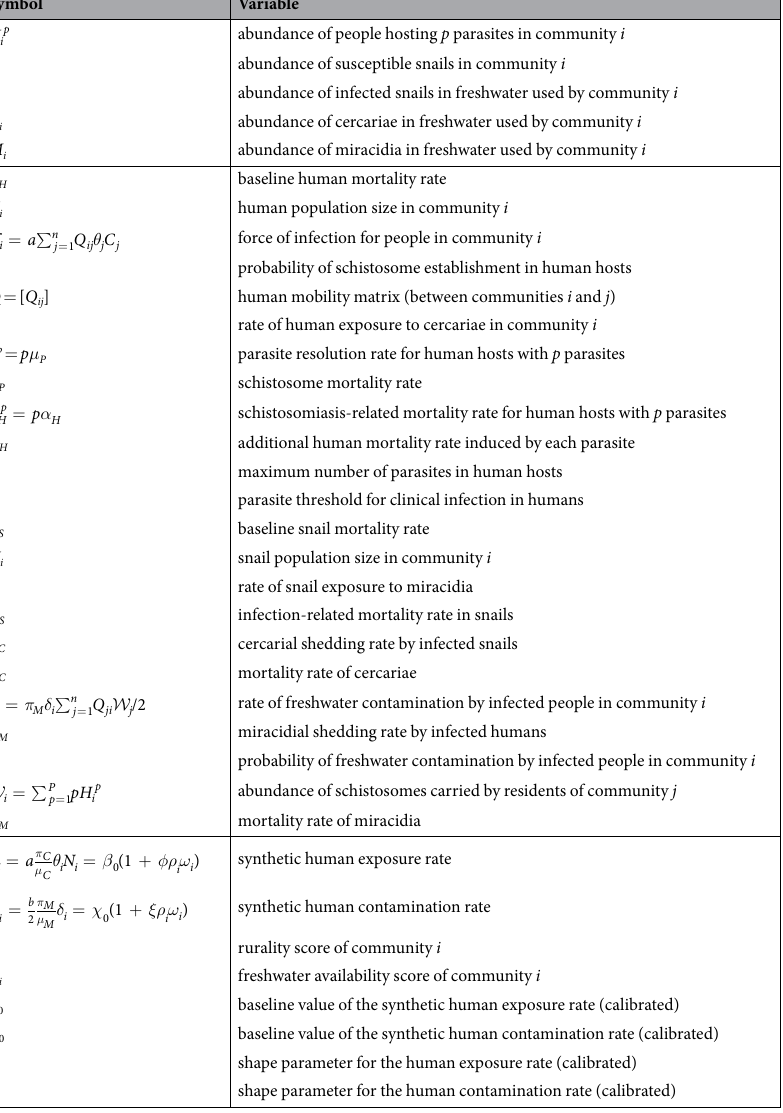
Table 1. Model variables and parameters. The top and middle parts of the table summarize the state variables and the parameters of the schistosomiasis transmission model described in the Methods section, while the bottom part describes the synthetic human exposure and contamination rates obtained after introducing equilibrium assumptions for larval abundances and rescaling the remaining state variables (see SI for